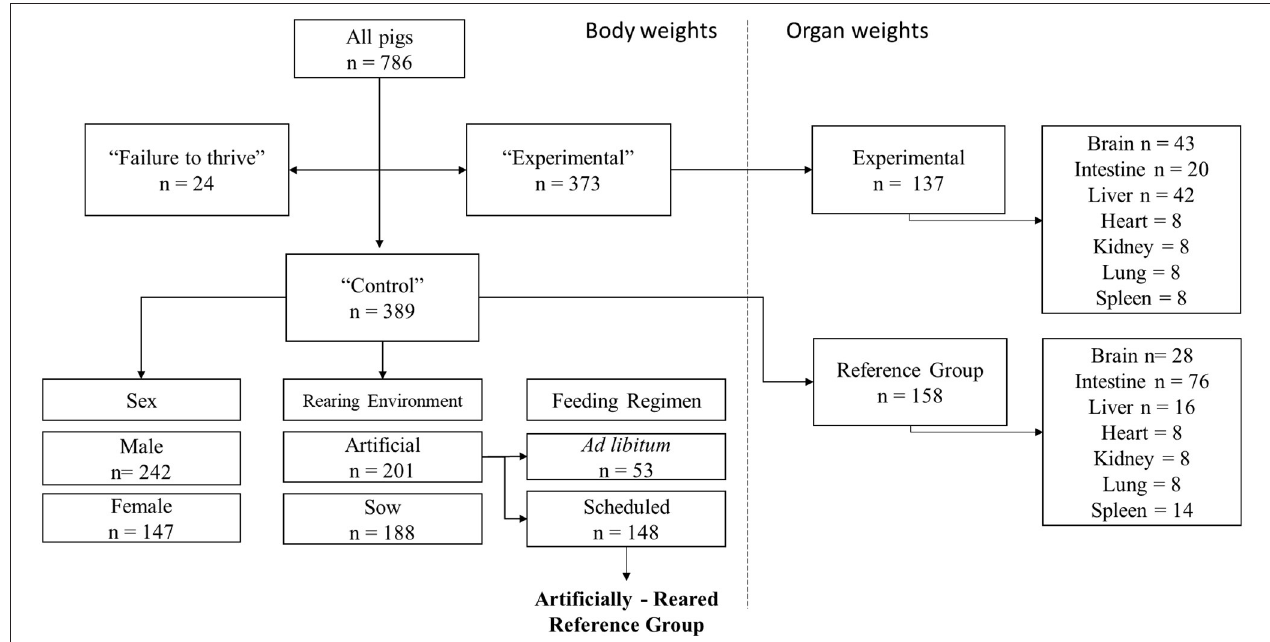
FIGURE 1 | Schematic for the different inclusion and exclusion categories for database construction. Data from all 786 pigs available in total were separated into three main categories consisting of failure to thrive, Control, and Experimental groups. Control and Experimental pigs represent those fed a control or experimental diet in their respective study. Control pigs were then subcategorized by sex, rearing, and feed styles. Artifically-Reared pigs fed in a scheduled manner were then selected as reference group for assessment of typical body weight growth. Available organ weights from Control and Experimental groups were also then captured. Samples were pooled together, independent of sex, rearing environment, and feeding regimen.